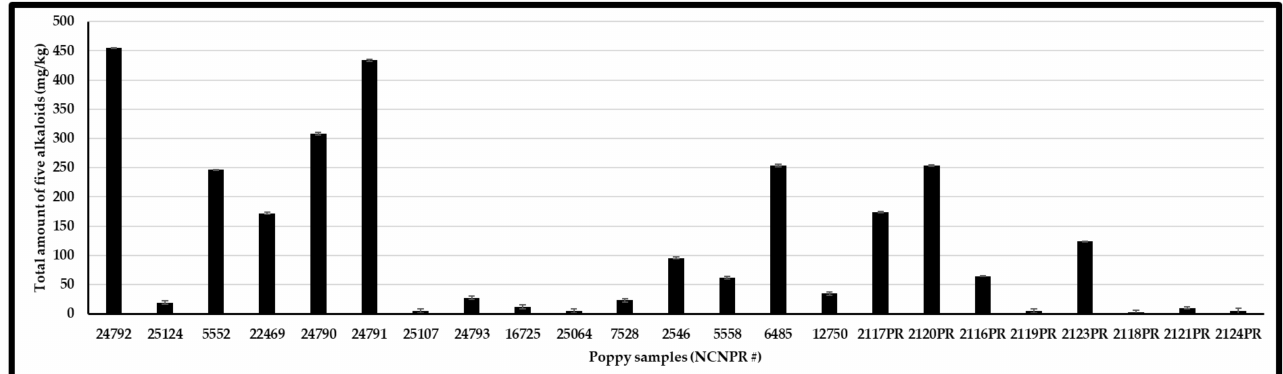
Figure 5. Content of alkaloids ( µ g/g) observed in different poppy seed samples. The area of a slice in each pie chart is proportional to the individual alkaloid’s content ( µ g/g).